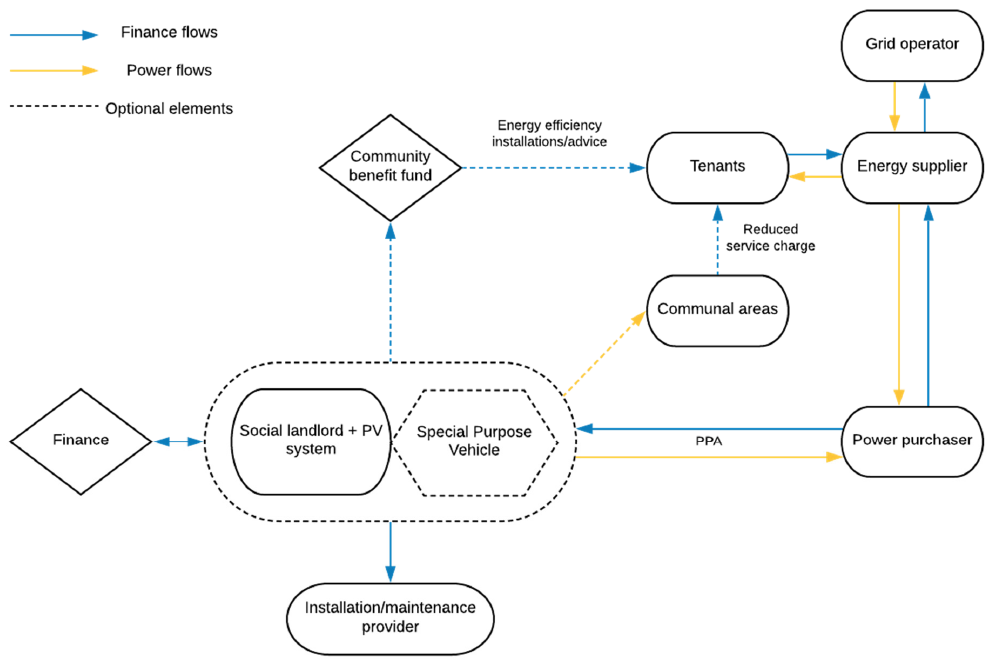
Figure 2. ‘Export’ flowchart adapted from ‘Figure 23: Typical onsite private wire PPA business model structure’ in Dunlop and Roesch [45]. Additions of community benefit fund, powering communal areas and tenant benefits derived from interview and workshop data.